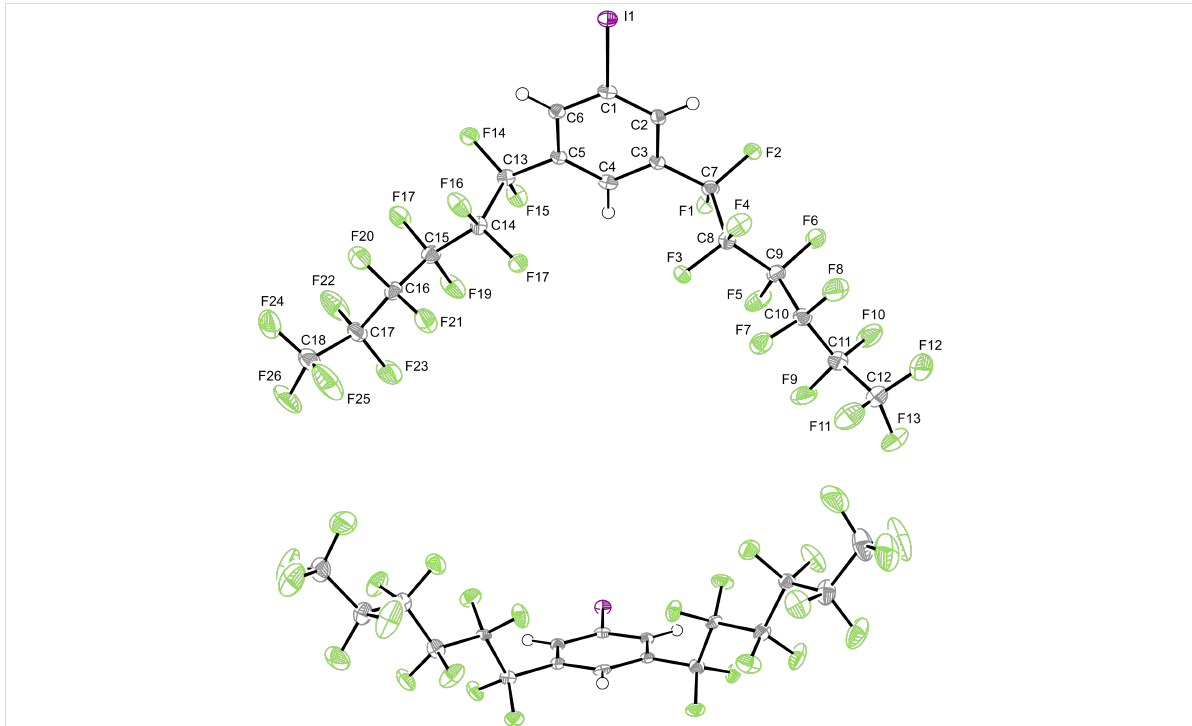
Figure 2: Two views of the molecular structure of 1,3,5-(R f6 ) 2 C 6 H 3 I with thermal ellipsoids at the 50% probability level. Key bond lengths (Å) and angles (°): C1–I1 2.099(3), C1–C2 1.391(4), C2–C3 1.386(4), C3–C4 1.393(4), C4–C5 1.387(4), C5–C6 1.393(4), C6–C1 1.394(4), C3–C7 1.501(4), C5–C13 1.508(4), average of 10 CF–CF 1.545(5), I1–C1–C2 119.0(2), C1–C2–C3 118.8(3), C2–C3–C4 121.0(3), C3–C4–C5 119.2(3), C4–C5–C6 121.1(3), C5–C6–C1 118.5(3), C6–C1–C2 121.4(3), C6–C1–I1 119.5(2), C2–C3–C7 119.7(2), C4–C3–C7 119.3(2), C4–C5–C13 119.6(2), C6–C5–C13 119.3(2), average of 8 CF–CF–CF 115.0(10).